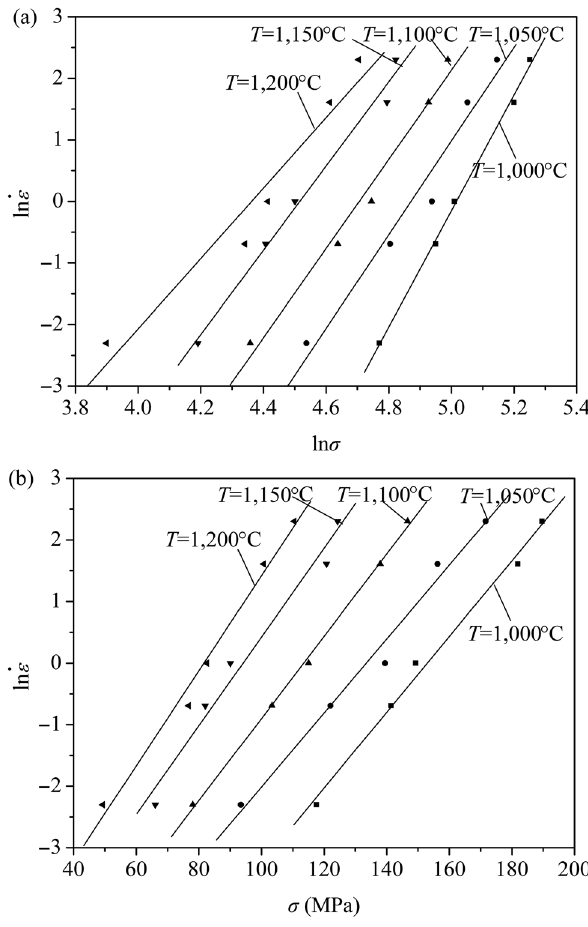
Figure 7: Relationships (a) between ln _ ε and ln σ and (b) between ln _ ε and σ